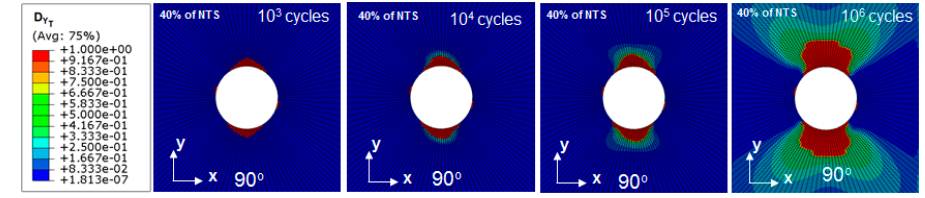
Figure 18. Reduction in strength S 23 in each ply of the OHT specimen after 10 6 cycles.